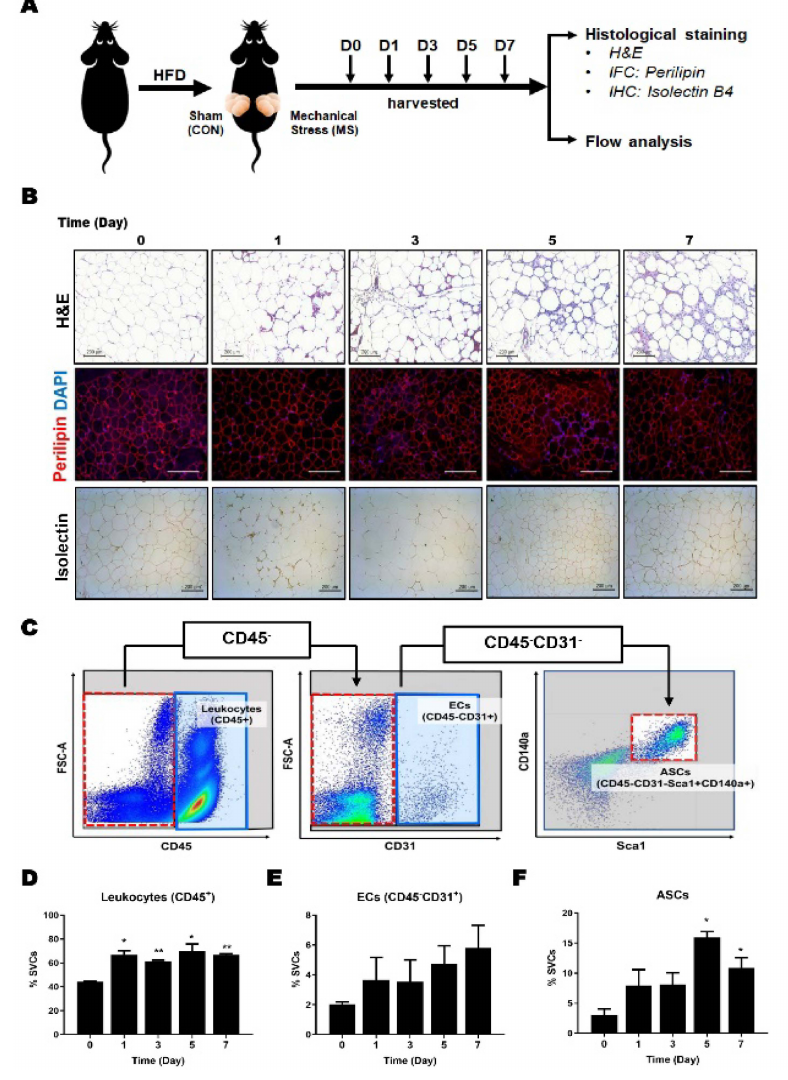
Figure 1. Effects of mechanical stress on adipose tissue histology and cellular composition. Me- chanical stresses were performed by needling 25 times with 21-gauge needle on the right unilateral inguinal fat pads of mice. After procedures, fat pads were isolated at different time points (days 0, 1, 3, 5 and 7) and followed by histological or flow cytometry analysis. ( A ) Schematic diagram of experimental design; ( B ) Representative image of H & E (upper), immunostaining of Perilipin (red) and DAPI (blue) (middle) and immunostaining of isolectin B4 (bottom) with 10 × magnification; ( C ) Gating strategy for leukocytes, endothelial cells (ECs), and adipose-derived stem cells (ASCs); ( D ) Quantitation of leukocytes (CD45 + ) in adipose tissue; ( E ) Frequency of ECs (CD45 − CD31 + ) in adipose tissue; ( F ) Frequency of ASCs (CD45 − CD31 − CD140a + Sca1 + ) in adipose tissues. Data are means ± SEM ( n = 6). * p < 0.05; ** p < 0.01 versus day